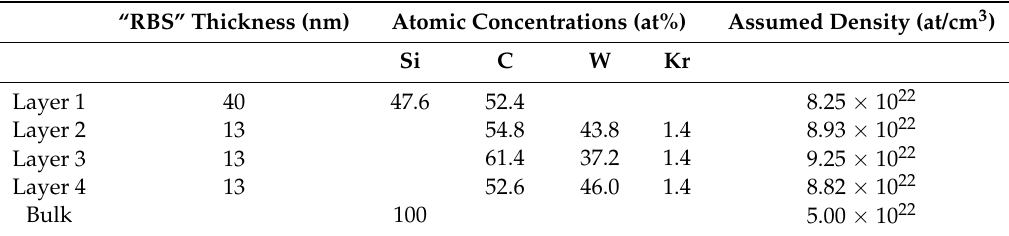
Figure 14. The plot in the top right corner shows full RBS spectrum of as-deposited and annealed WC/SiC sample, consisting of only two layers, each 40 nm thick and deposited directly on Si substrate. These two spectra are basically indistinguishable. Peak between channel 50 and 280 comes from the Si substrate. The small peak at ~310 is due to the Si in the SiC layer. The peak between 370 and 400 is due to Kr and between 390 and 420 is the W in the WC layer. Experimental data of W peak in as-deposited sample (black dots) with theoretical fit (black line) and of annealed sample (red dots) with theoretical fit (red line) are plotted again in the main plot to show details. Table 5. Thickness, atomic concentrations and assumed densities of SiC (layer 1) and WC (layers 2–4) and Si substrate (bulk) in as-deposited state as determined from RBS analysis and fits. “RBS” Thickness (nm) Atomic Concentrations (at%) Assumed Density (at/cm 3 )